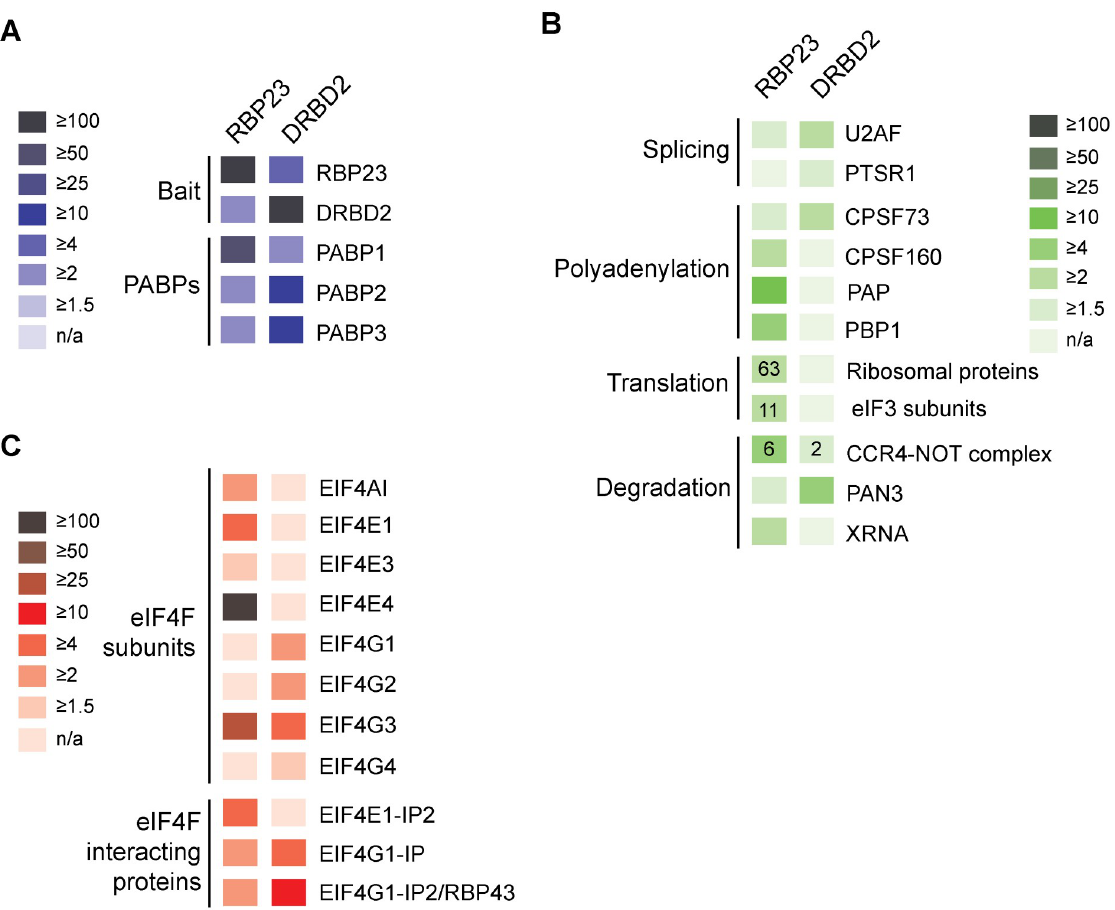
Fig 5. Comparative enrichment ratios for the major protein groups co-precipitated with L . infantum HA-tagged RBP23 and DRBD2. Proteins co-precipitated with RBP23 and DRBD2 belonging to the selected functional categories related to mRNA processes are represented by boxes coloured according to the enrichment ratios derived from S3 and S5 Tables. The numbers inside the boxes indicate the number of subunits of the named complex (including ribosomes) that have equivalent enrichment ratios. ( A ) Enrichment ratios for the baits and three PABP homologues. ( B ) Enrichment ratios for eIF4F subunits and eIF4F interacting proteins. ( C ) Enrichment ratios for other proteins with functions related to mRNA splicing, polyadenylation, translation or